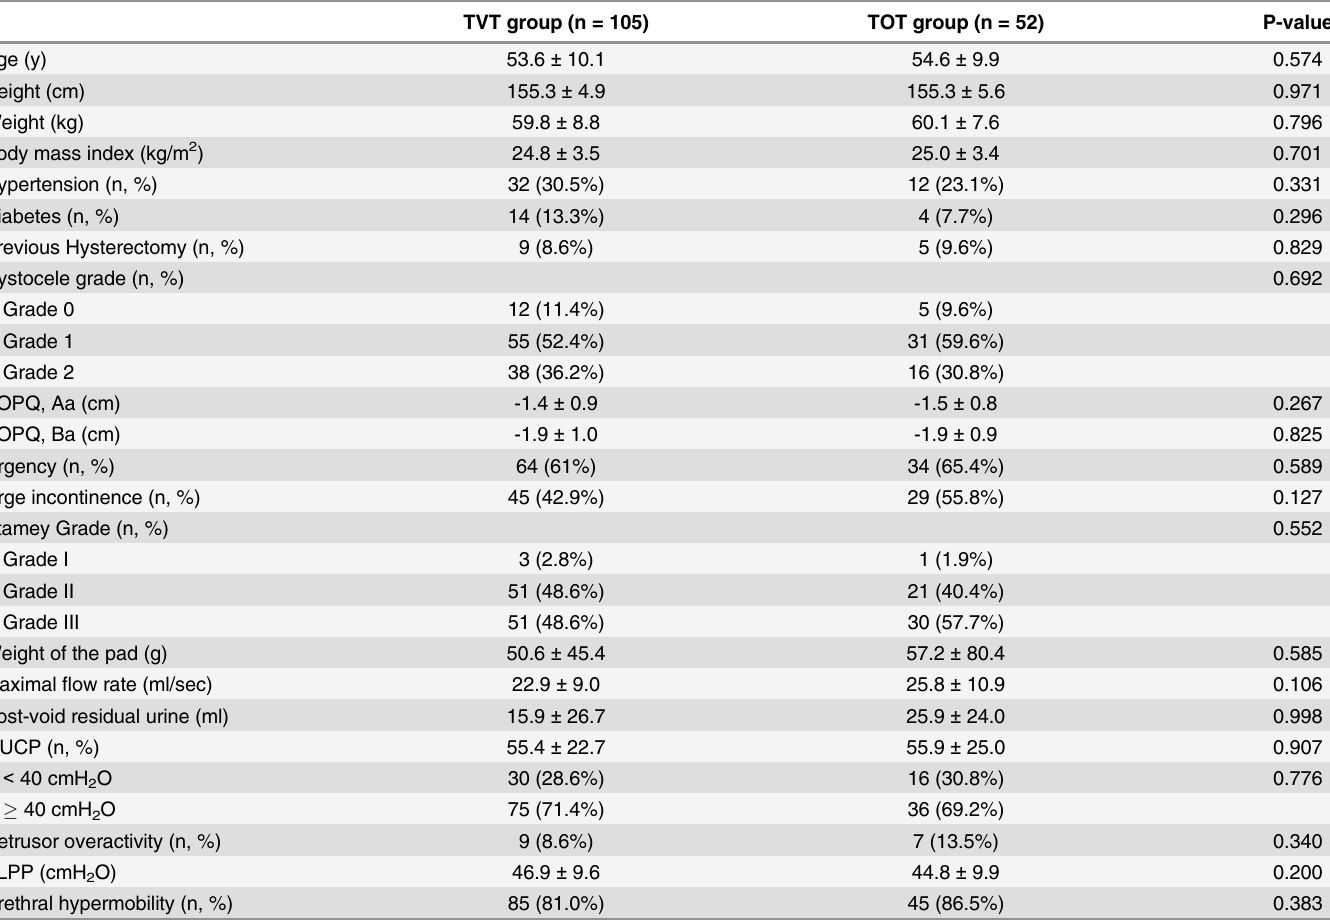
Table 1. Comparison of baseline characteristics between the TVT and TOT